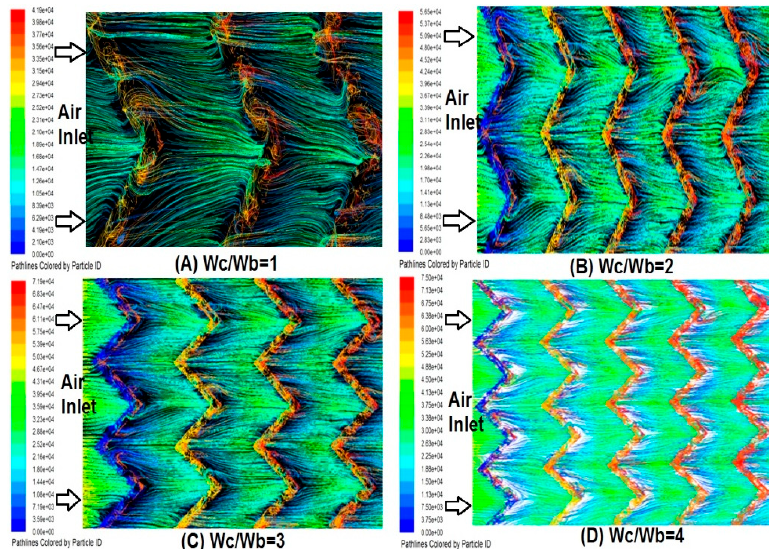
Figure 8. Contour plot of path lines for ( A ) Wc / Wb = 1, ( B ) Wc / Wb = 2, ( C ) Wc / Wb = 3, and ( D ) Wc / Wb = 4 ( e/H = 0.6, P/e = 8.0, O/e = 0.42, β = 12%, α = 60°, and R e = 5000).